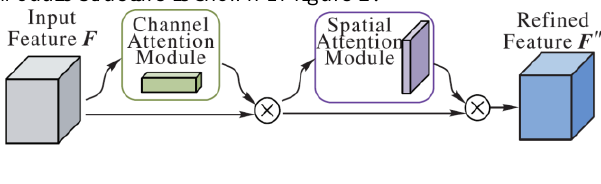
Figure 2. Module structure of CBAM